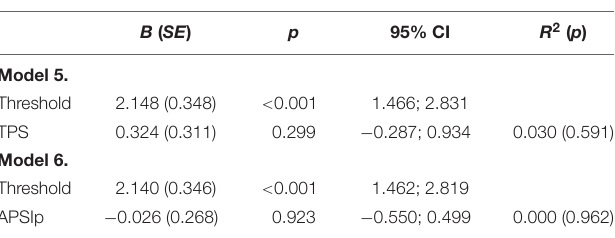
TABLE 5 | Multi-level-models predicting the risk to delay ( Y = 1) vs. work on a task ( Y = 0), based on individual differences in trait- and state-procrastination tendencies.